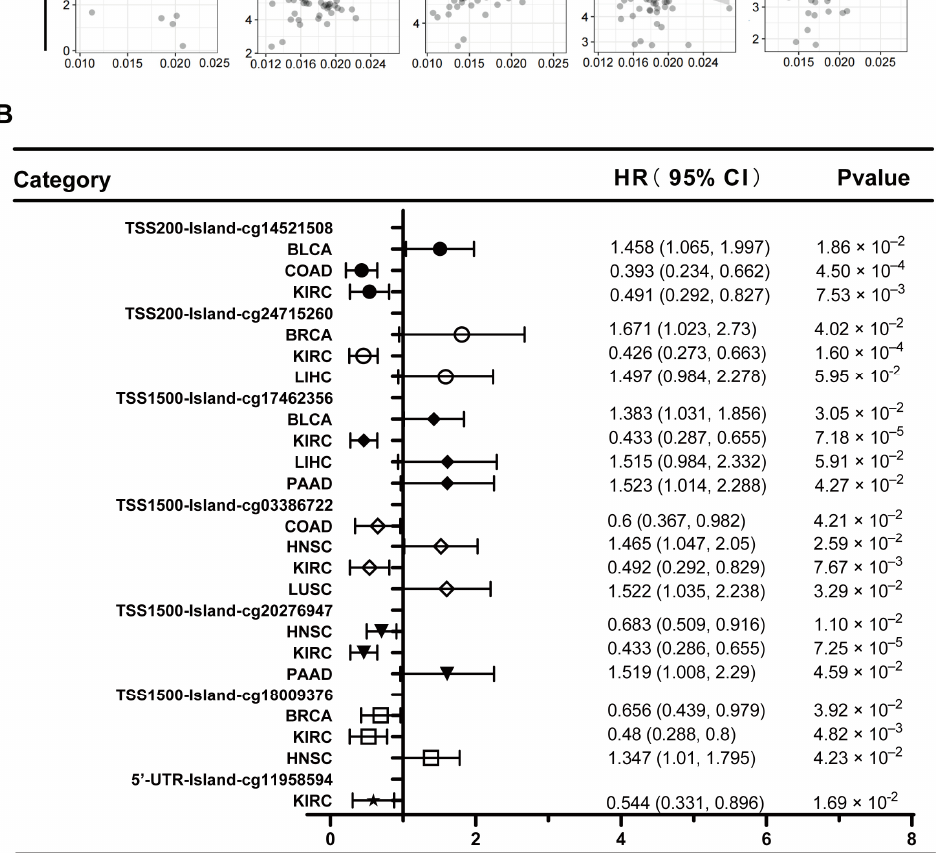
Figure 8. Correlation analysis of FASN promoter methylation and expression and prognostic analysis of seven FASN methylation probes in ten cancer types. ( A ) Correlation of DNA methylation at the cg24715260 probe position with FASN expression in ten tumors. ( B ) Prognostic analysis of seven probes in ten cancers with positive results ( p < 0.05) forest plots are given.